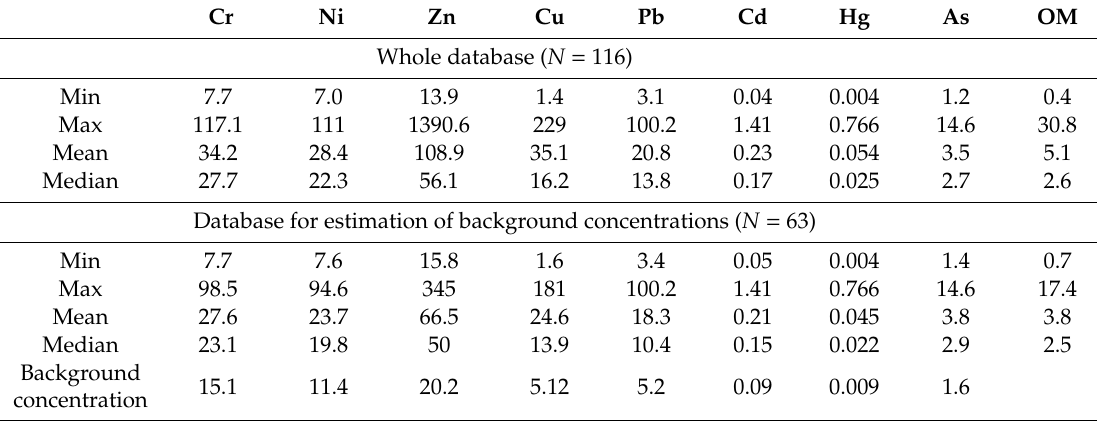
Table 1. Minimal and maximal value, mean and median of each metal ( µ g / g dry weight) and organic matter (OM) content (%) in the whole database and the database used for the estimation of background concentrations. Background concentration (10th percentile) of each metal.